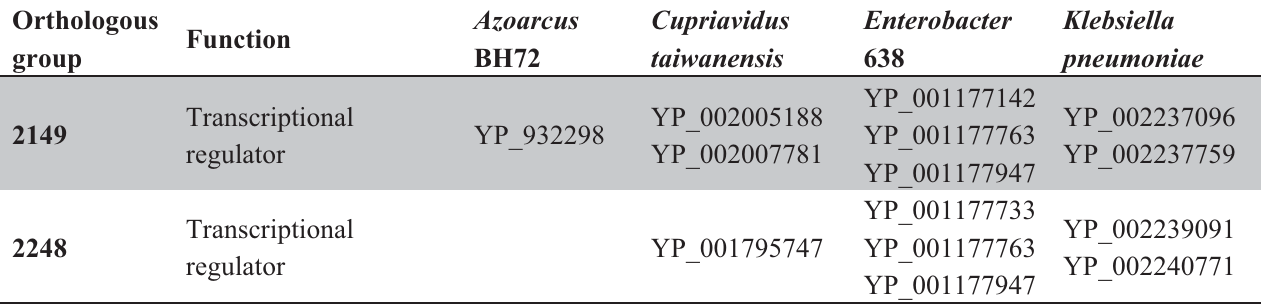
Table 1. Phylogenetic conservation of plant-associated orthologous groups in other plant-associated bacteria. The hit for each genome is indicated as GenBank accession number of the corresponding